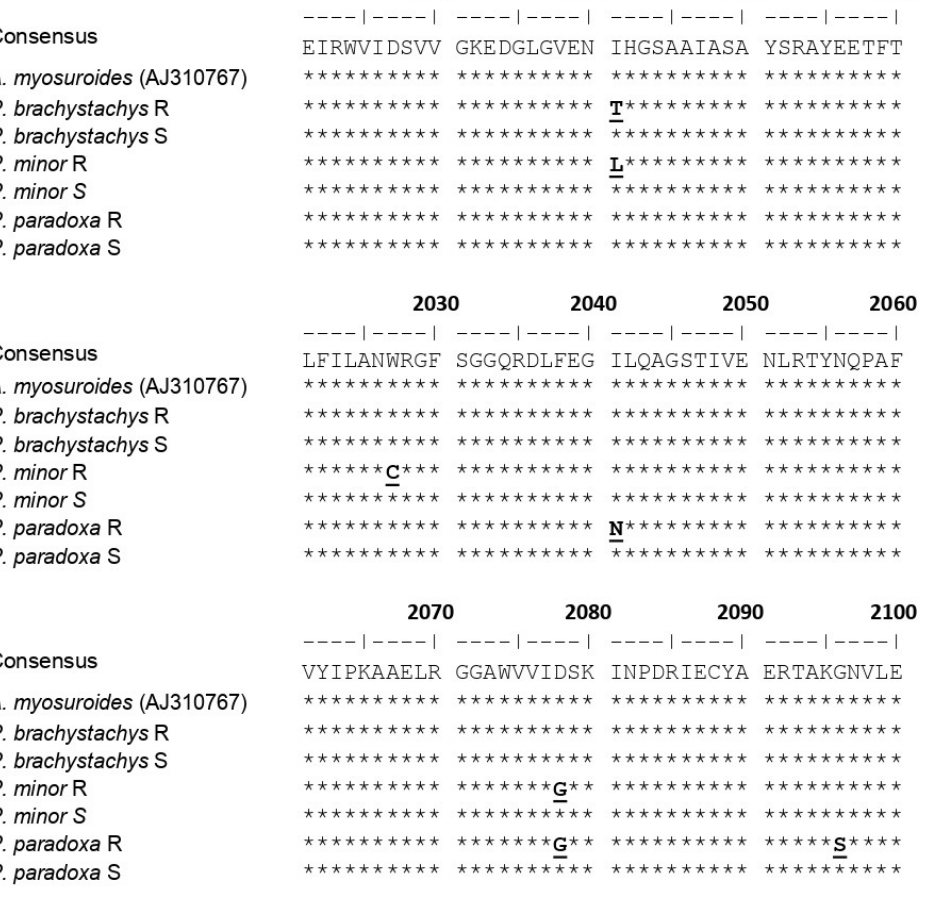
Figure 2. Amino acid substitutions in the A and B regions of the carboxyl transferase (CT) domain of the homomeric chloroplast acetyl CoA carboxylase (ACCase) gene in susceptible (S) and resistant (R) Phalaris biotypes.